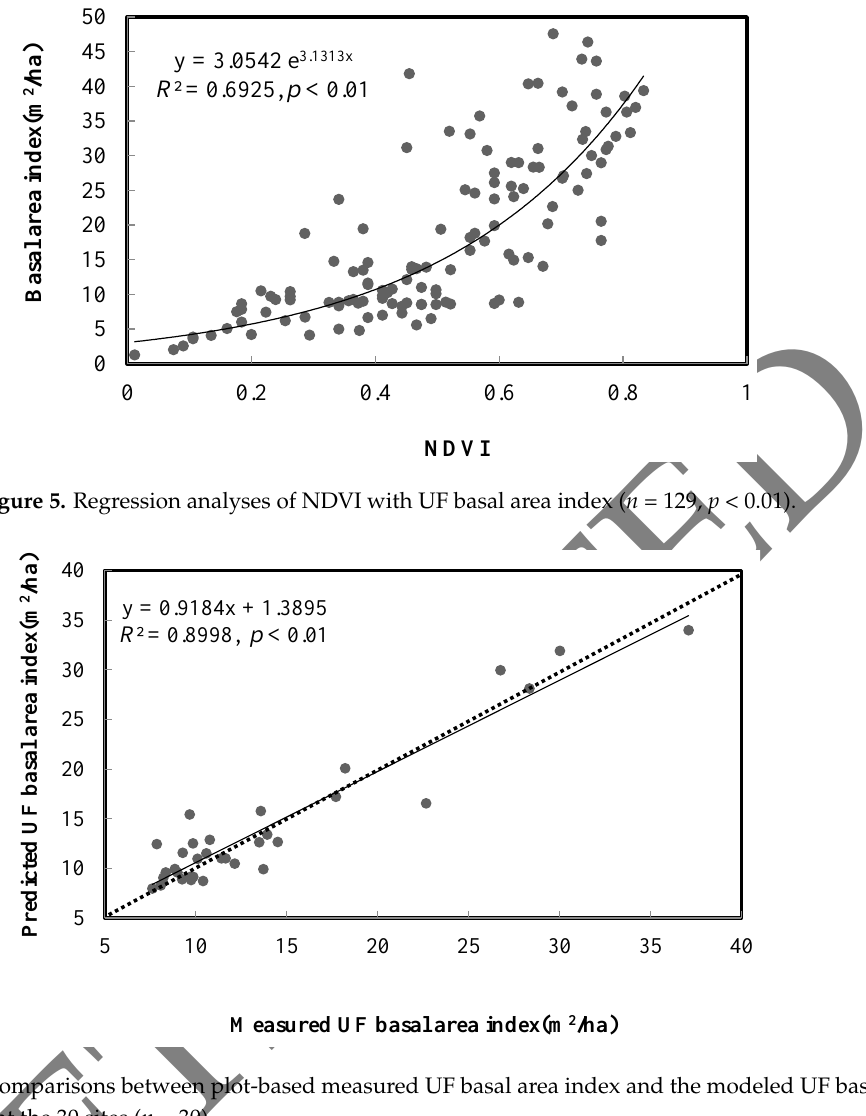
Figure 6. Comparisons between plot-based measured UF basal area index and the modeled UF basal area index at the 30 sites ( n = 30).